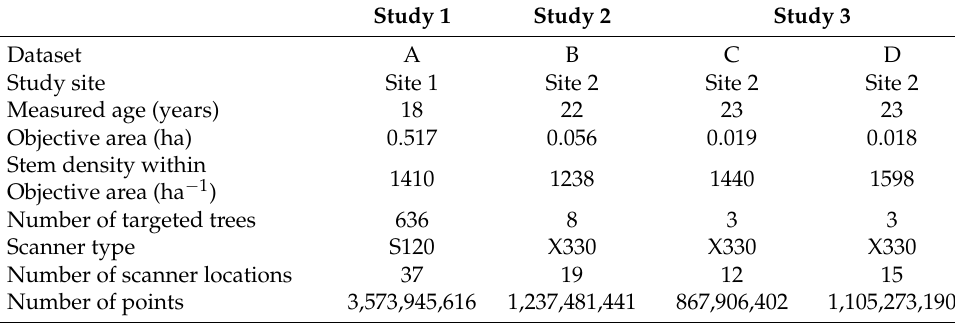
Table 1. Summary of three studies conducted at Site 1 and Site 2.